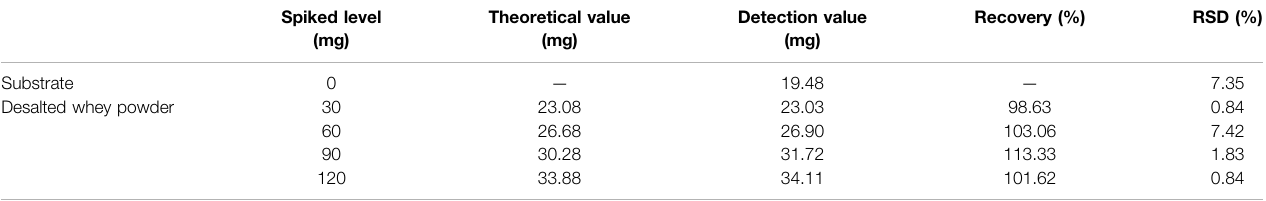
TABLE 4 | Spiked recovery rate ( n = 3).